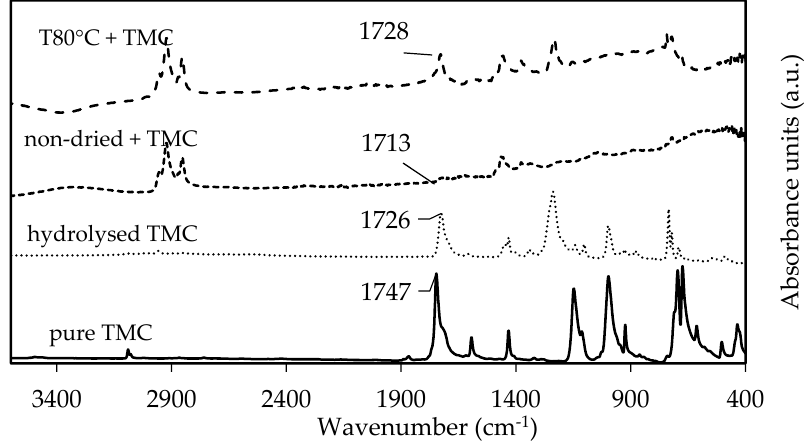
Figure 9. ATR-FTIR spectra of 1.5 wt% pure TMC (full line), hydrolyzed TMC (striped line), TMC in non-dried (dotted line), and vacuum-dried Aliquat at 80 °C (striped line).